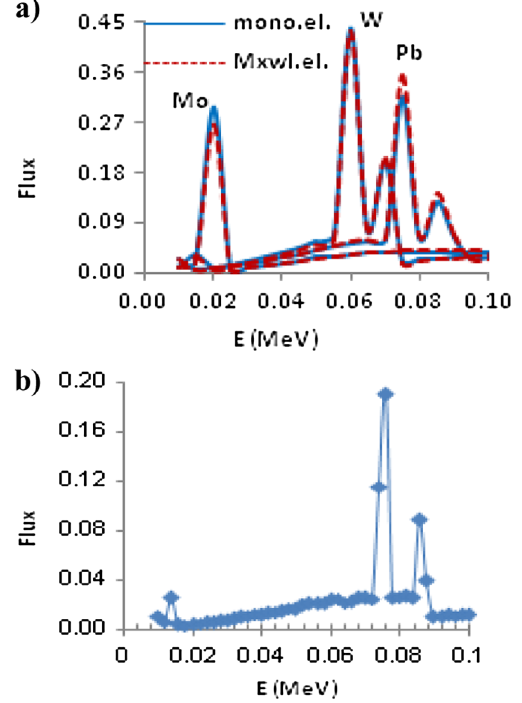
FIG. 3. (a) The production of x ray from the experimental q -monoenergetic and the normalized q -Maxwellian electrons of Fig. 2 by MCNP-4C code for three targets of Mo, W, and Pb with equal thicknesses of d ¼ 400 (cid:5) m ; (b) the same as (a) for Pb with the q -monoenergetic electron profile, achieved by higher energy resolution, showing several characteristic